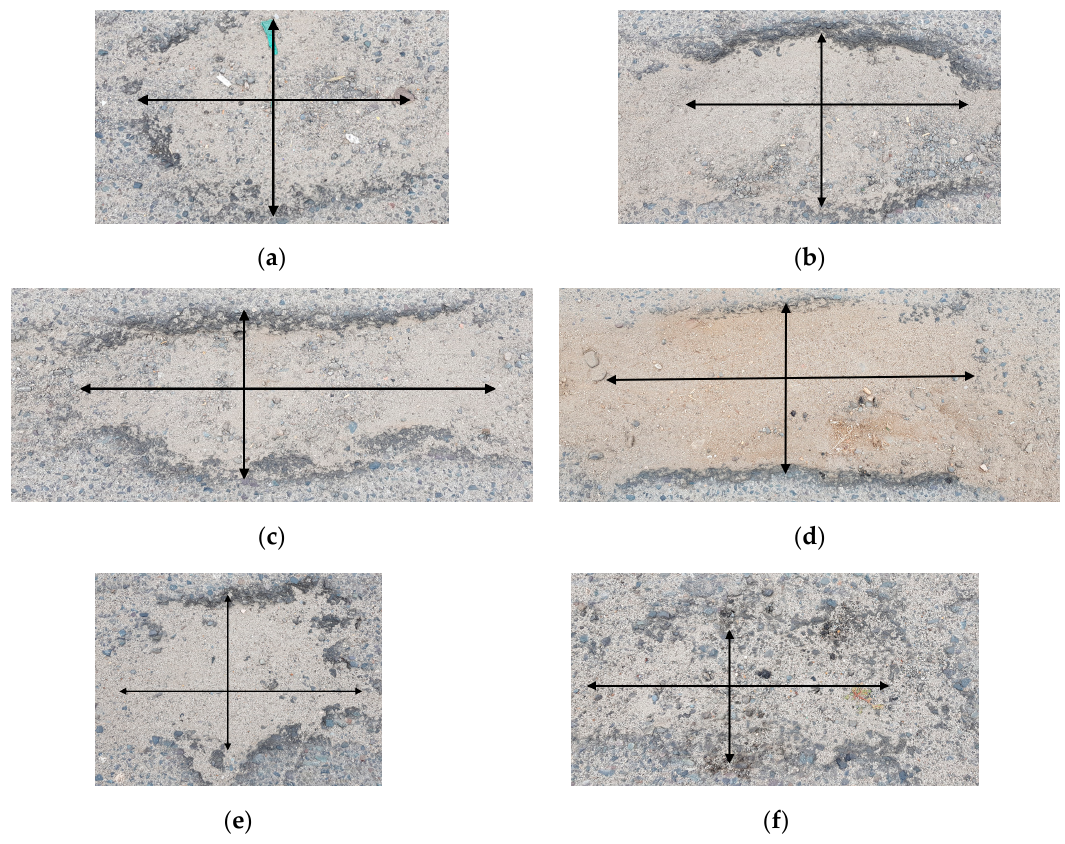
Figure 12. Flexible pavement pothole for recommendation validation. Table 6. Dimensions of potholes measured in terrain (real).